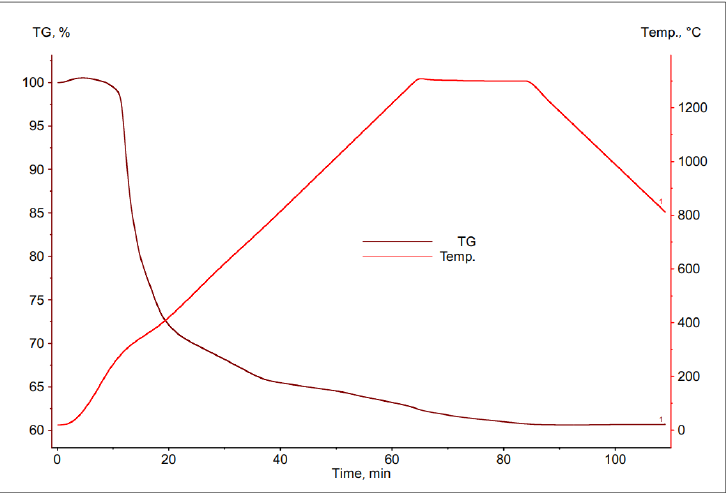
Figure 8. Change in mass of a sample with grain size 3.15 ÷ 6.3 mm during its heating.